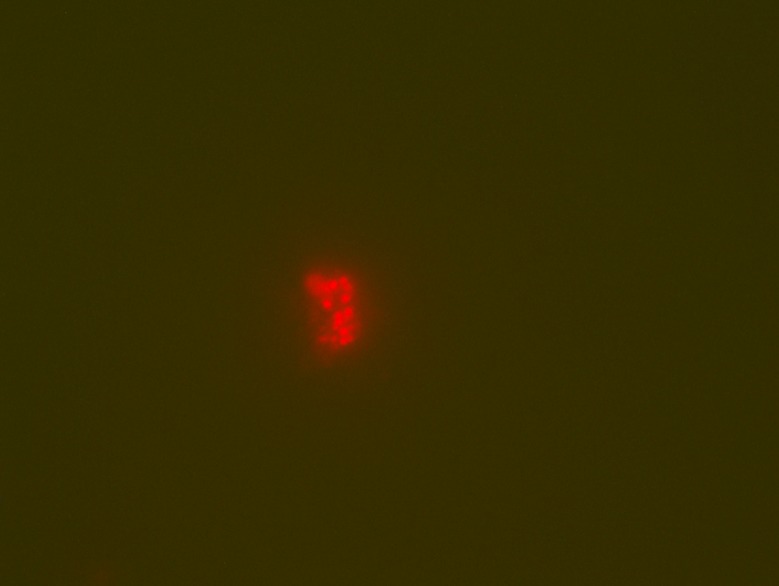
EDTA demineralised Late Cretaceous surface eroded fossil bone at 691 m elevation in Dinosaur Provincial Park showing possible cell clusters as might be expected in a biofilm (image 4).Sample ID as in Appendix 1—table 2: 16B.